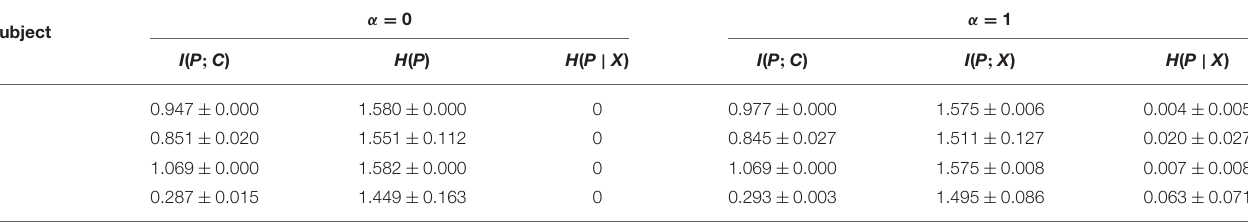
TABLE 1 | Information-theoretic quantities for the results of the information bottleneck algorithm.